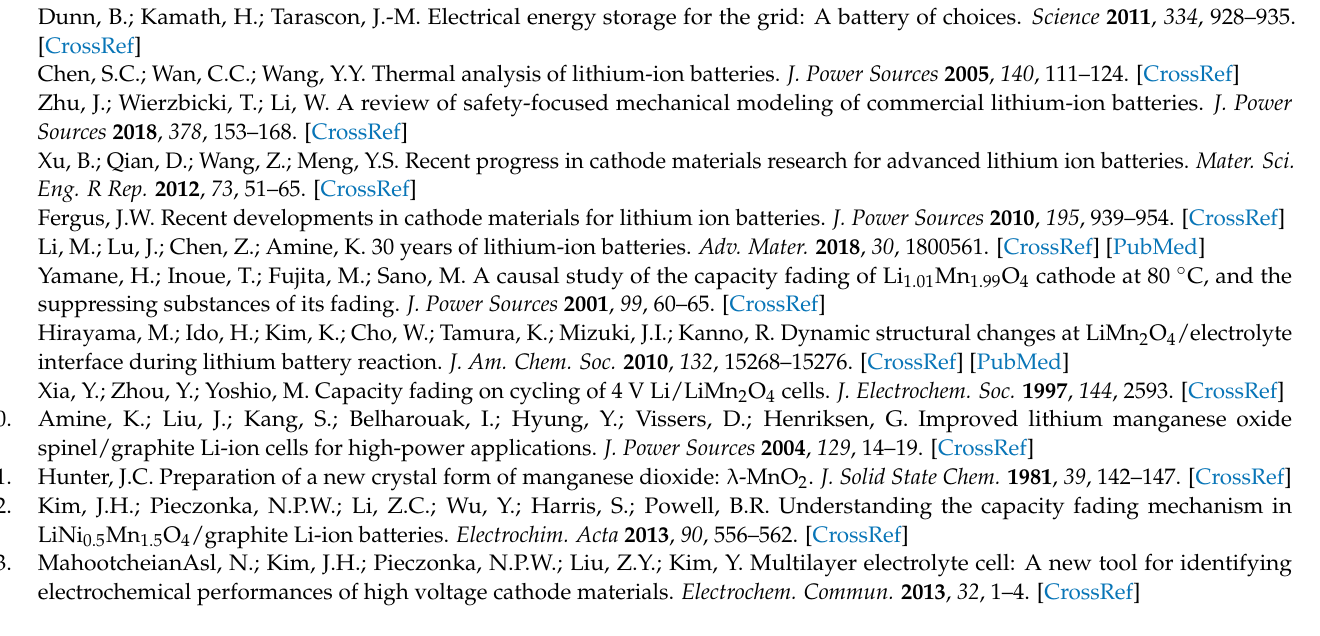
Figure S5: Nyquist plots of LMO/graphite cells with and without P2 additive. The cells were cycled three times and set to SOC 100 before the EIS